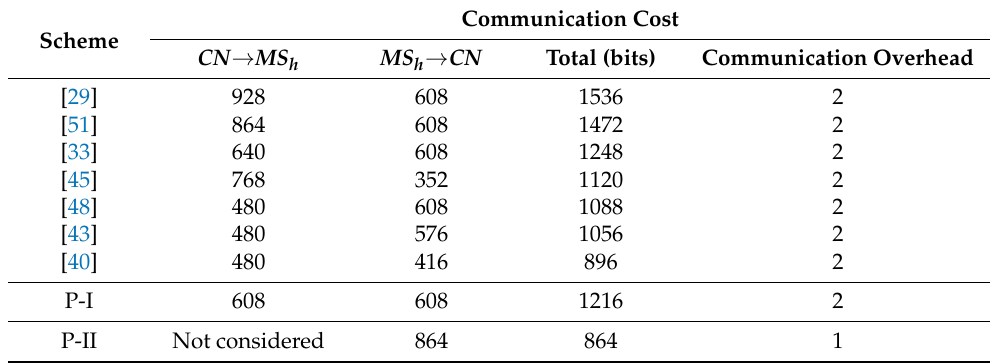
Table 5. A communication costs